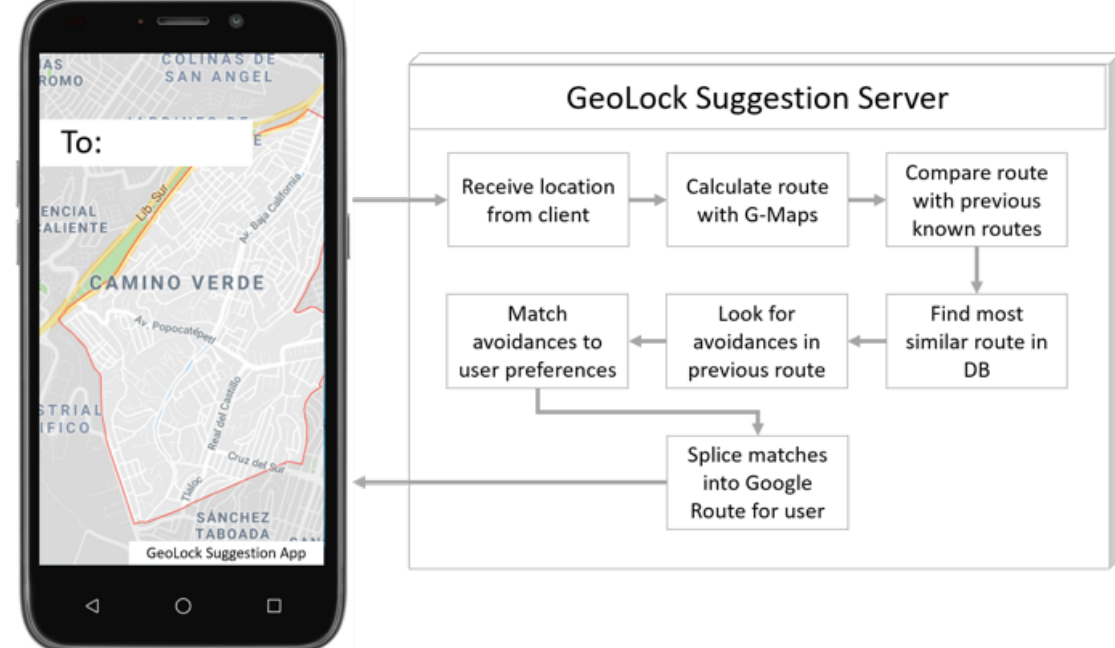
Figure 11. Example screen of app and flowchart for our GeoLock-based Suggestion